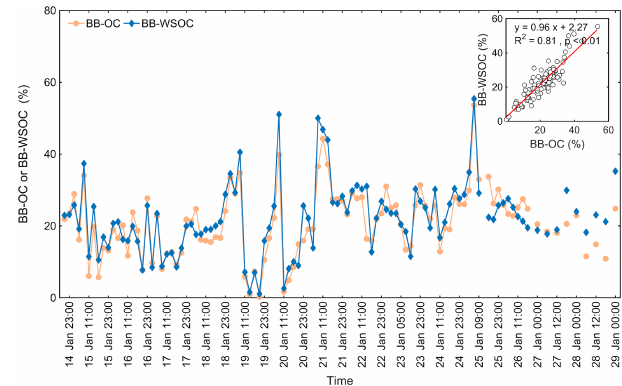
Figure 5. Time series of biomass burning contribution to OC (BB- OC) and WSOC(BB-WSOC) and the correlation between them.